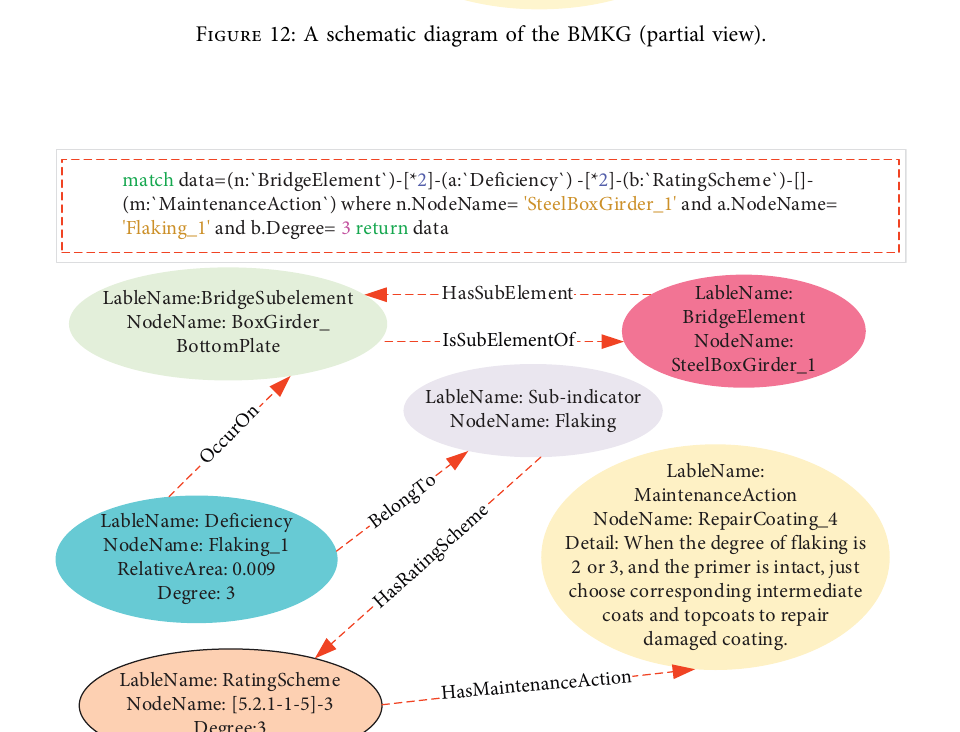
Figure 13: Te query result of the maintenance